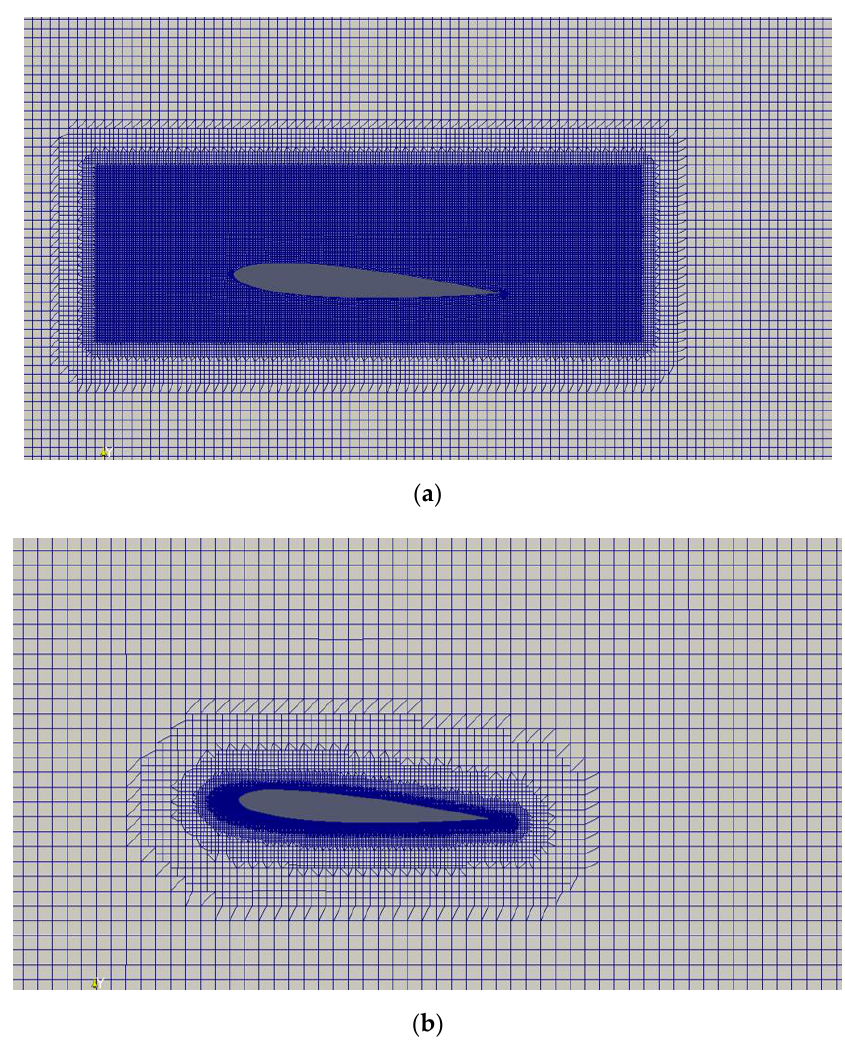
Figure 3. Computational mesh around NACA0012 hydrofoil. ( a ) Mesh with SST k- ω turbulence model. ( b ) Mesh with Smagorinsky turbulence model.